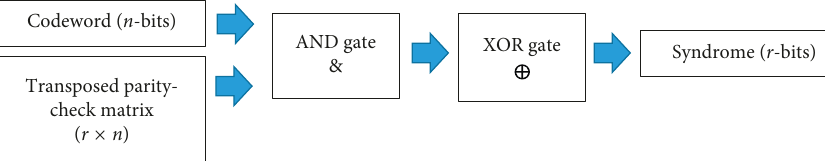
Figure 6: Gate/graphical expression of hamming decoder formula.